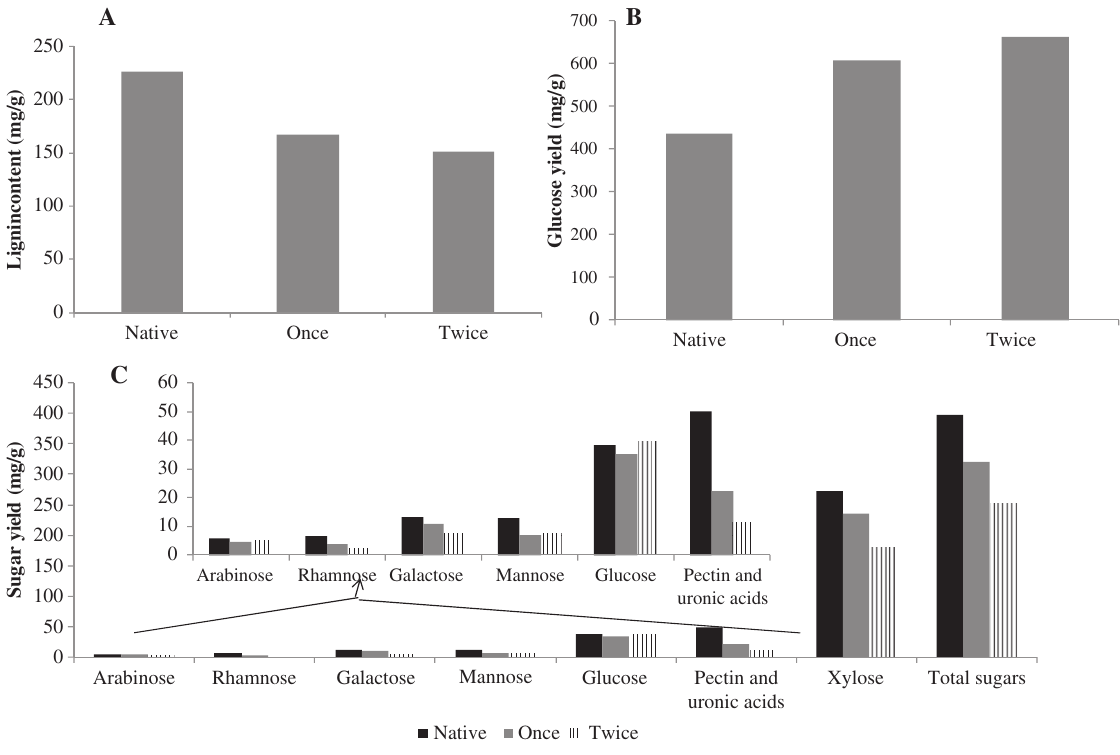
Figure 1 (A) Lignin content; (B) cellulose content (glucose yield); (C) hemicelluloses content (sugar yield) for native birch chip and dietha- nolamine (DEA)-CO2-switchable ionic liquid (SIL)-treated birch once-treated and twice-treated, using fresh SIL in both treatments at 100 ° C for 24 h and in the absence of stirring.